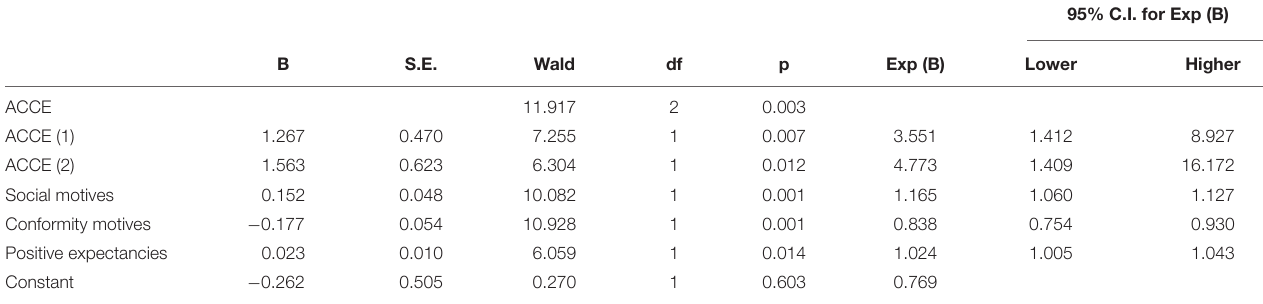
TABLE 4 | Logistics regression on binge drinking (BD) according to ACCE, positive expectancies, and social and conformity